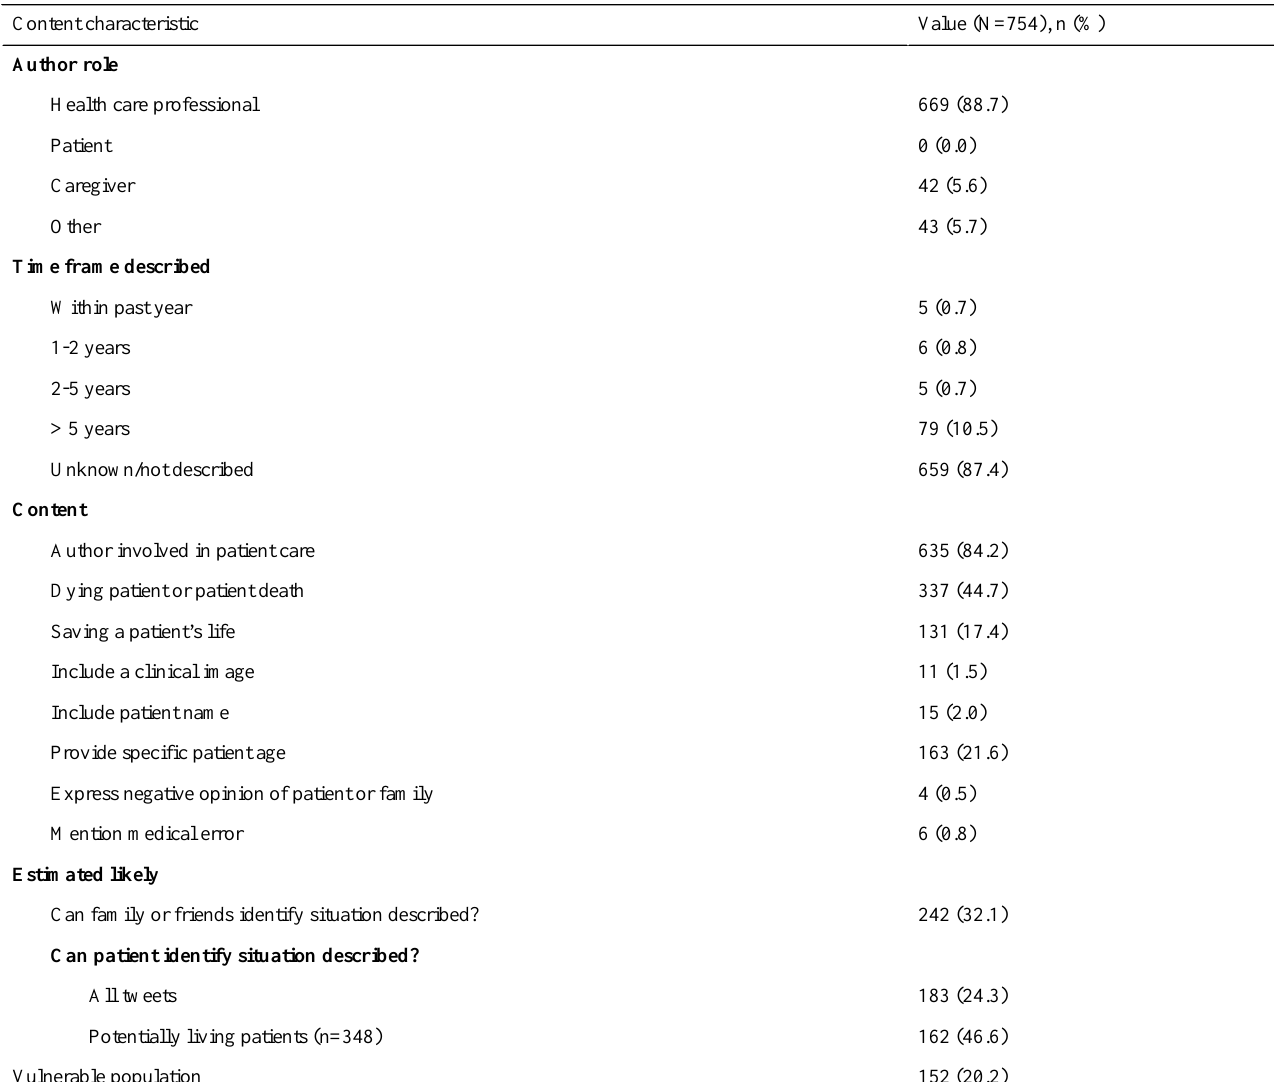
Table 2. Content characteristics tweets with disclosures about